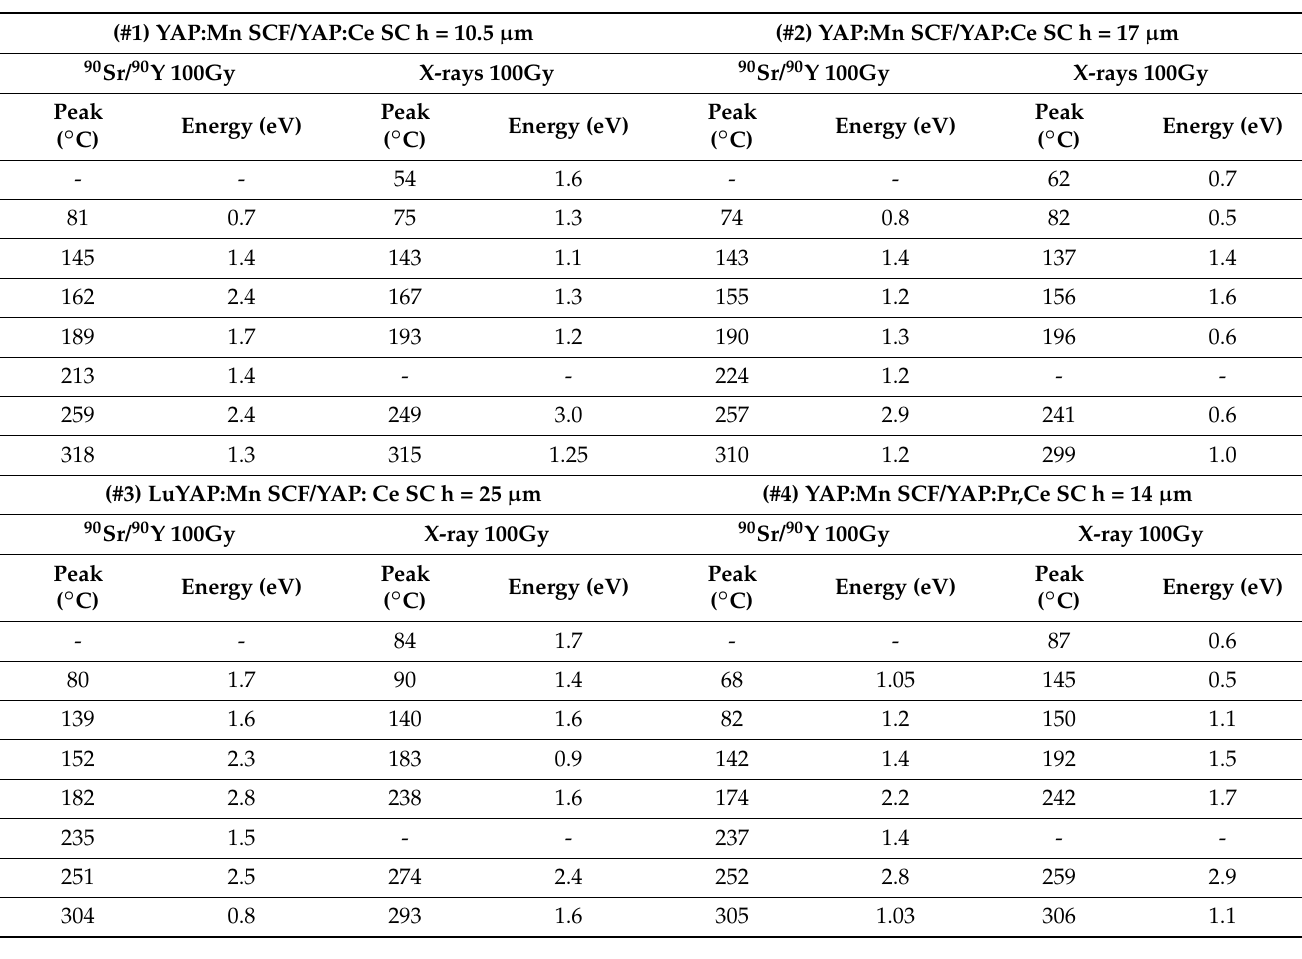
Table 3. The sets of peaks from sample #1, #2, #3, and #4 curves after irradiation by X-ray source or excitation by β -particles of 90 Sr/ 90 Y